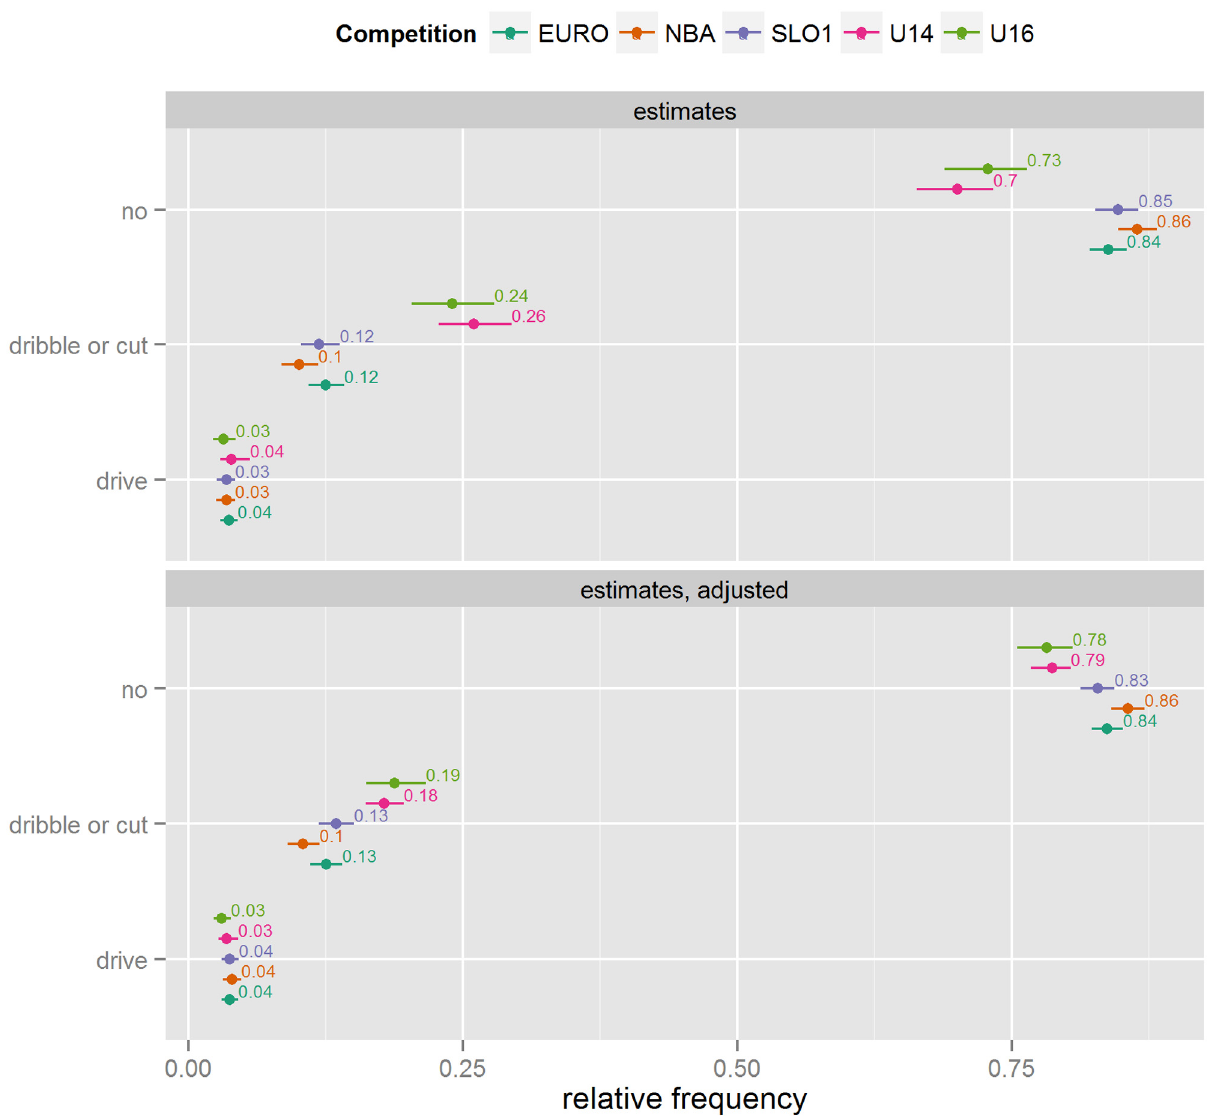
Fig 4. Movement frequency estimates (unadjusted and adjusted for differences in situational